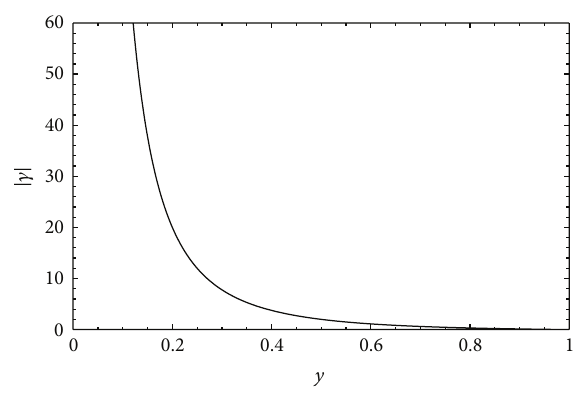
Figure 2: Plot of |𝛾(𝑦)| for 𝜖 ≤ 𝑦 ≤ 1 .